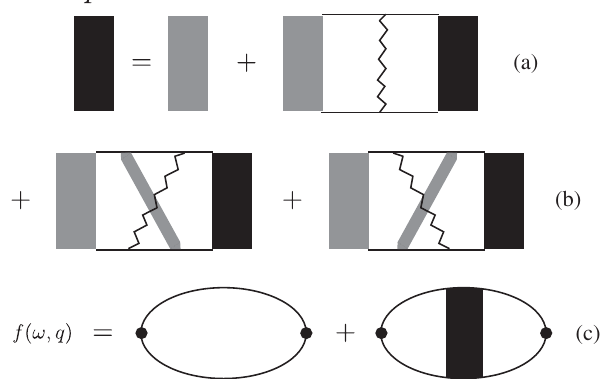
FIG. 5. Ladder insertions at O ð e 2 Þ , which provide exponen- tially growing contributions to f ð t; x Þ . The “ direct ” insertion in diagram (a) provides a contribution that grows at a rate propor- tional to T 2 , slower than the “ exchange ” insertions in diagram (b), which grow as T 3 = 2 . The relationship between the function f ð ω ; q Þ and the ladder series is shown in diagram